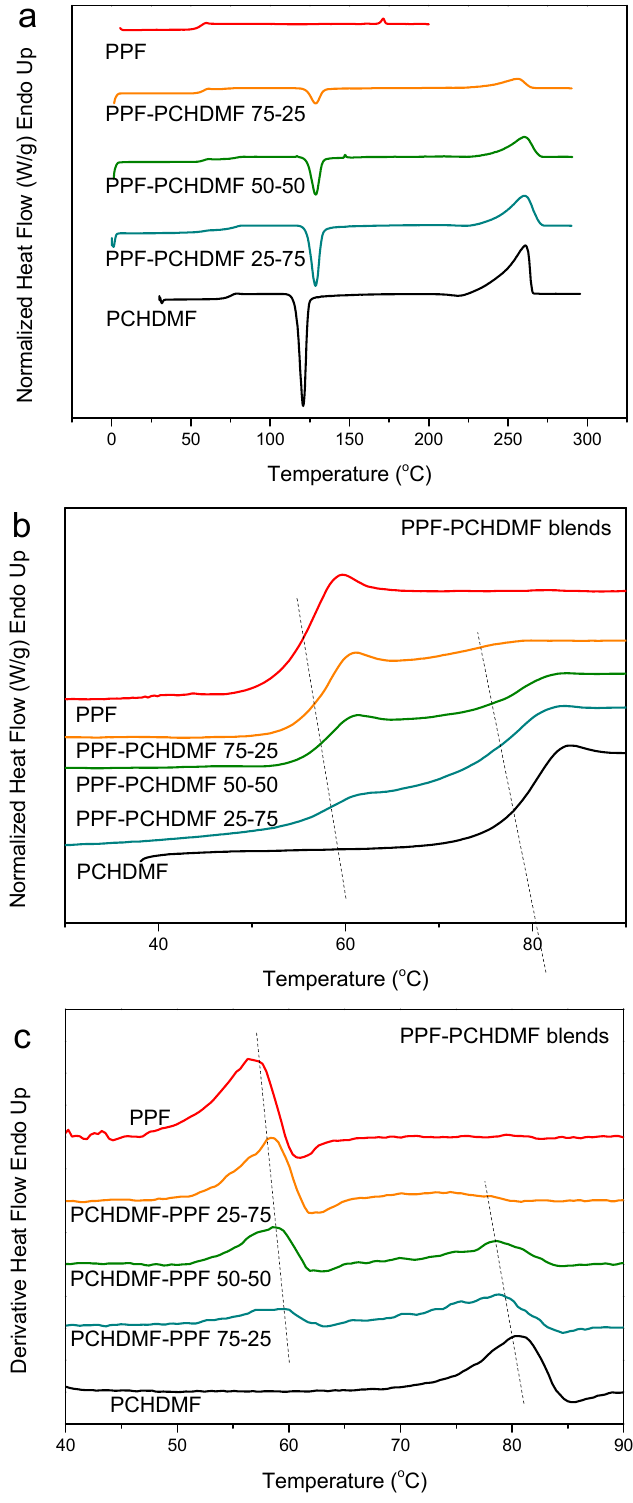
Figure 8. ( a ) DSC heating thermograms, ( b ) details of DSC thermograms in the T g region and ( c ) derivative heat flow for melt-quenched PCHDMF–PPF blend samples.